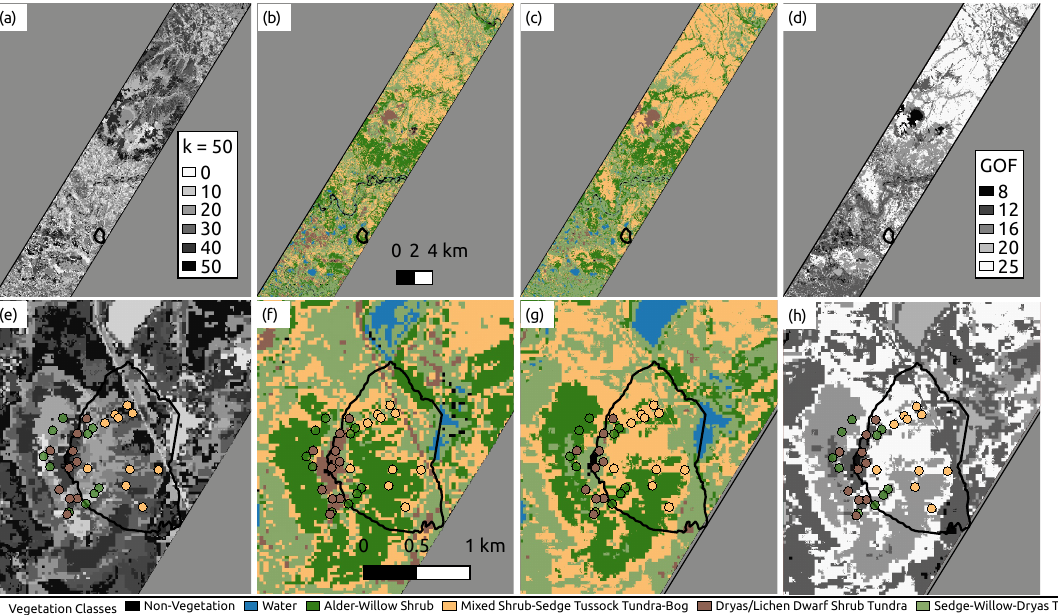
Figure 5. ( a ) Unsupervised classification map ( k = 50) of the study region using multi-sensor dataset. ( b ) The AKEVT map for the study region. ( c ) The UCVM map of the study region based on unsupervised clustering. ( d ) Map showing the GOF scores for UCVM- k 50 across the study region. ( e ) Unsupervised cluster ( k = 50) map of the Kougarok watershed. ( f ) The AKEVT map for the Kougarok watershed. ( g ) The UCVM- k 50 map for the Kougarok watershed based on unsupervised clustering. ( h ) The GOF scores map for UCVM within the Kougarok watershed. The circles represent the field datasets, color-coded for the vegetation